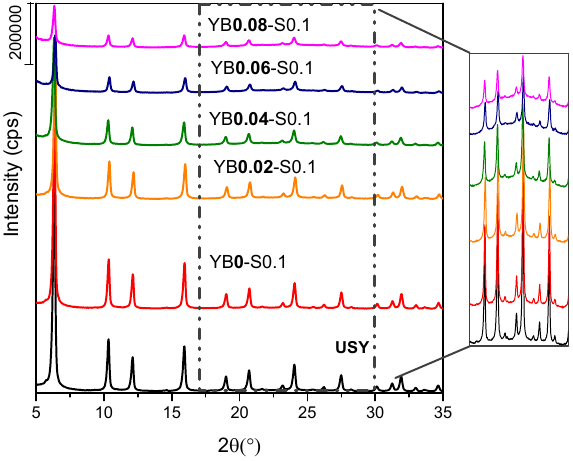
Figure 6. X-ray diffractograms of the modified zeolites produced using different base ratios.